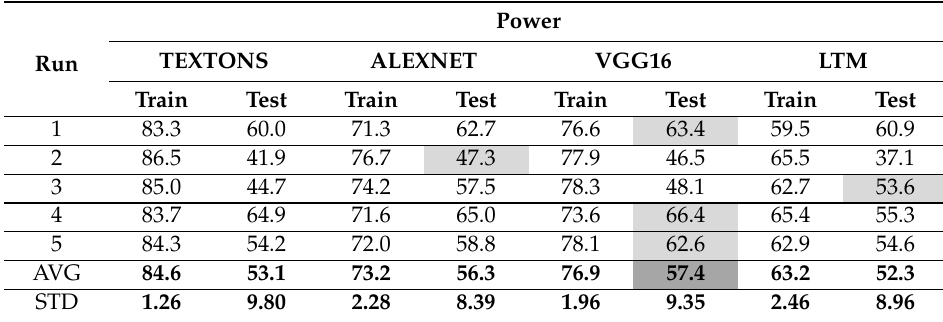
Table 3. Results of classification (% correct) with predictor sets derived from the mill power data and use of a cubic kernel support vector machine.